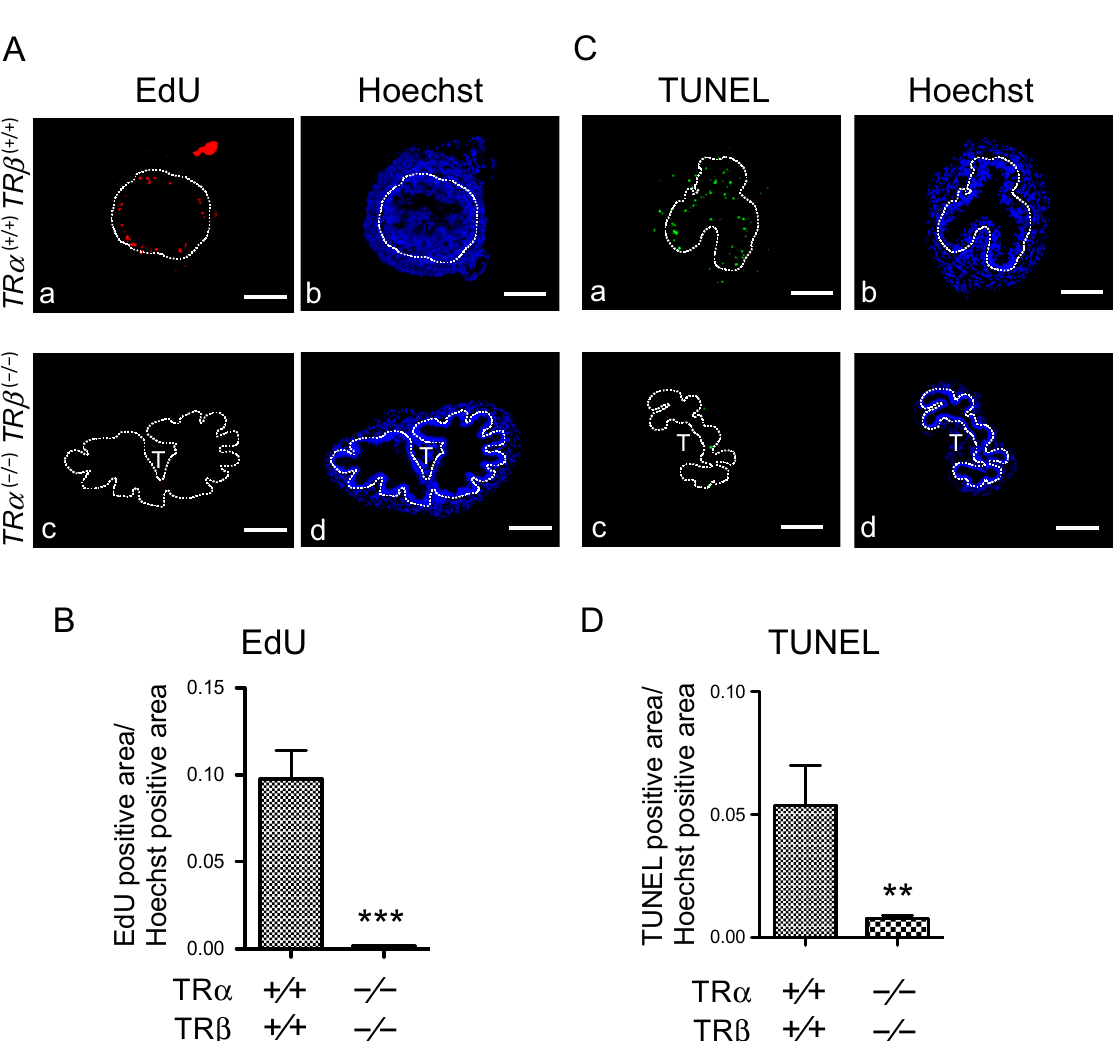
Figure 3. TRDKO tadpoles have little or no cell proliferation or apoptosis at the climax of metamorphosis. ( A , B ) TRDKO inhibits epithelial cell proliferation. ( A ) Cross-sections of the intestine isolated from wild type ( a , b ) and TRDKO ( c , d ) tadpoles at stage 61 preinjected with EdU to label proliferating cells were stained for the presence of EdU. The dotted lines depict the epithelium–mesenchyme boundary, drawn based on morphological differences between epithelial cells and mesenchyme cells in the pictures of the stained tissues. EdU, red-color ( a , c ) and Hoechst, blue-color ( b , d ). T: typhlosole. Bars: 100 µ m. ( B ) Quantification of the EdU positive area from at least 3 tadpoles for each genotype. The statistical significance of differences was determined by Student’s t -test. ***, p < 0.0001. ( C , D ) TRDKO inhibits larval epithelial cell death. ( C ) Cross- sections of the intestine isolated from wild type ( a , b ) and TRDKO ( c , d ) tadpoles at stage 61 were subjected to TUNEL labeling for apoptotic cells and Hoechst 33342 staining for DNA. The dotted lines depict the epithelium–mesenchyme boundary, drawn based on morphological differences between epithelial cells and mesenchyme cells in the pictures of the stained tissues. TUNEL: green, and Hoechst: blue. T: typhlosole. Bars: 100 µ m. ( D ) Quantification of TUNEL-positive area from at least 3 tadpoles for each genotype. The statistical significance of differences was determined by Student’s t -test. **, p <